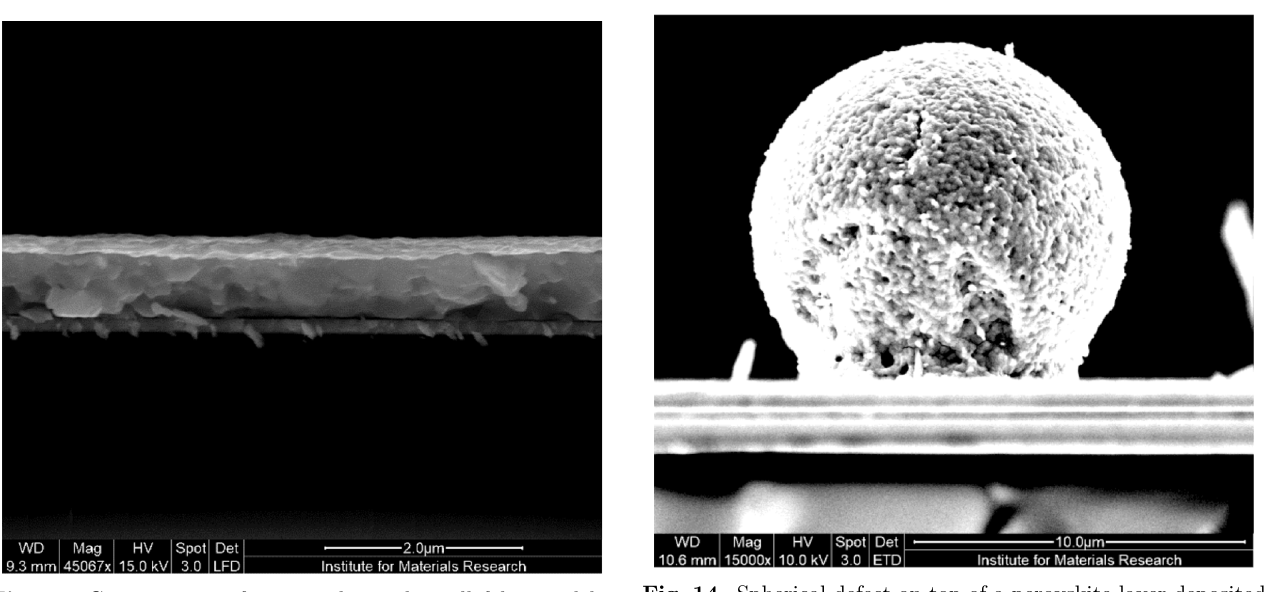
Fig. 13. Cross section of a perovskite solar cell fabricated by USSC and high pressure gas quenching, with 1M solution.